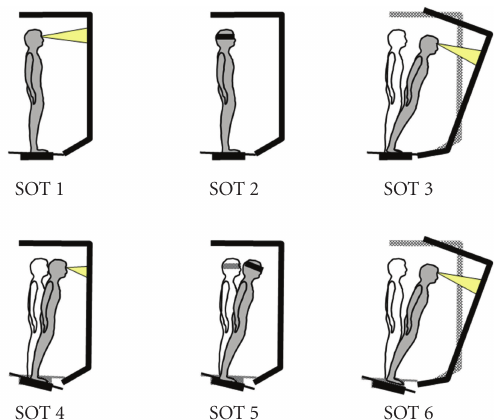
Figure 1: Test conditions SOT 1 to 6 under which equilibrium score